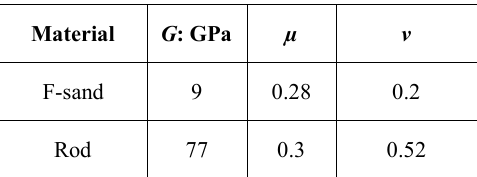
Fig. 1. View of DEM model of calibration chamber, rod and coordinate (originated at the center of the bottom wall)